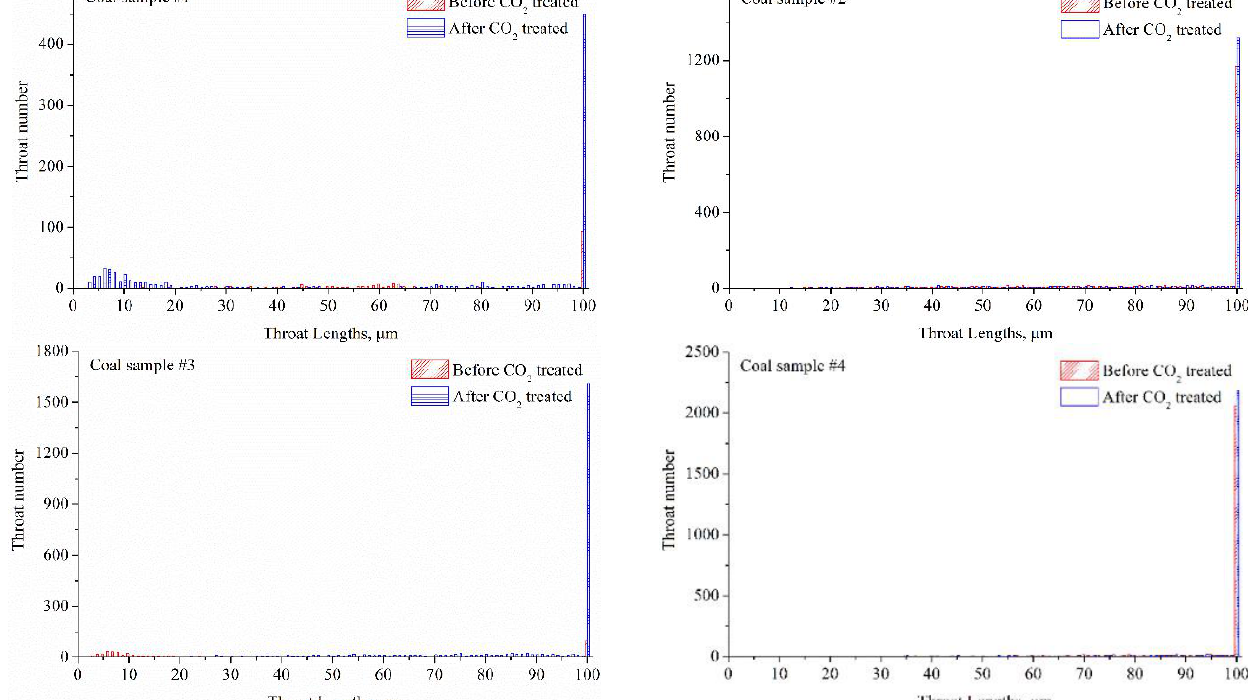
Figure 6— Throat lengths of coal samples based on X-ray